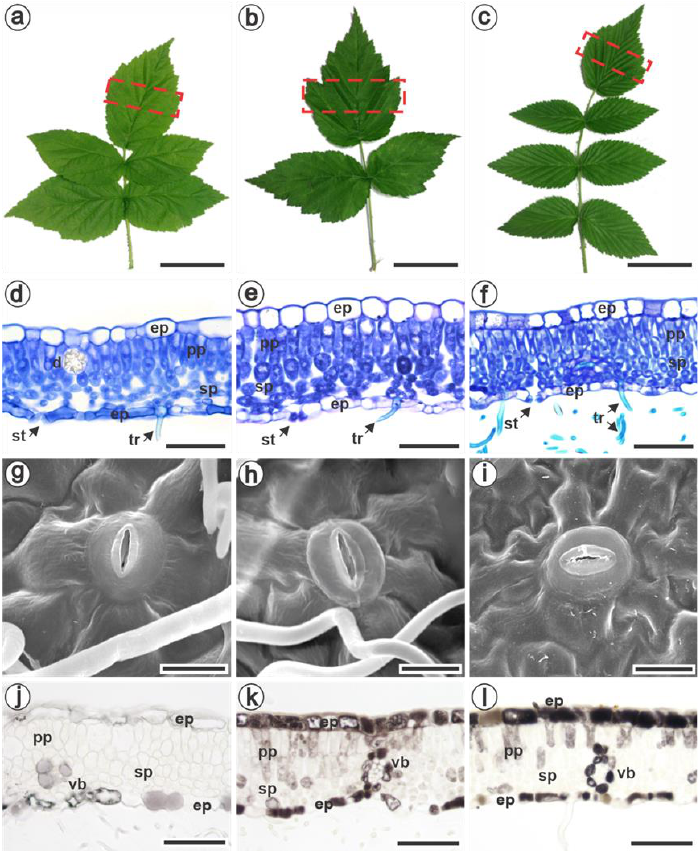
Figure 1. Mature leaves of Rubus idaeus cv. Autumn Bliss ( a ), R. occidentalis ( b ), and R. niveus ( c ). The dotted box on the terminal leaflet indicates the analyzed sector. Cross-sections of the leaflets’ lamina were stained with toluidine blue ( d – f ) and fixed in formalin-ferrous sulphate ( j – l ). ( d – f ) The uniseriate epidermis with larger cells on the adaxial face and the dorsiventral mesophyll with one ( d , e ) and two ( f ) layers of palisade parenchyma. ( g – i ) Scanning electron micrographs of anomocytic stomata. ( j – l ) Phenolic compounds (brown color) detected in epidermal, mesophyll and vascular bundle cells in all species, with lower intensity in R. idaeus ( j ). ep, epidermis; pp, palisade parenchyma; sp, spongy parenchyma; d, druse; st, stoma; tr, trichomes; vb, vascular bundle. Bars: ( a – c ): 5 cm; ( d – f , k – l ): 50 µ m; ( g – i ): 10 µ m; j : 60 µ